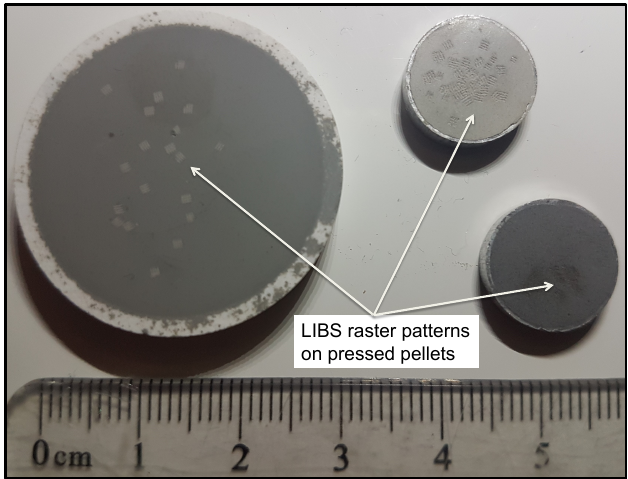
Figure 10. Example of pressed powder pellets showing a typical 12-position 3 × 4 LIBS analysis raster pattern.